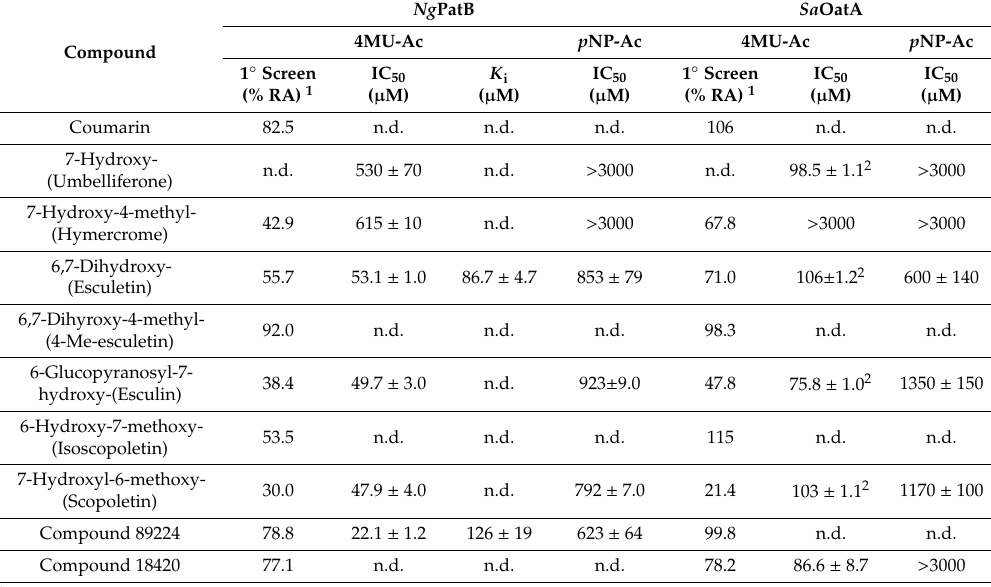
Figure 3. Pilot HTS for inhibitors of Ng PatB and Sa OatA. ( a ) Hit window of primary screen presenting the inhibition of Ng PatB ∆ 69 (red) and Sa OatA ∆ 435 (purple) by select coumarins present in the Bioactive Collection. Determination of dose dependence (IC 50 values) of inhibition of ( b ) Ng PatB ∆ 69 and ( c ) Sa OatA ∆ 435 by esculetin (compound 4 in panel ( a )), assayed with 4MU-Ac (red) and p NP-Ac (blue). Error bars denote standard deviation ( n = 3). Table 1. Inhibition of Ng PatB and Sa OatA by select compounds identified though